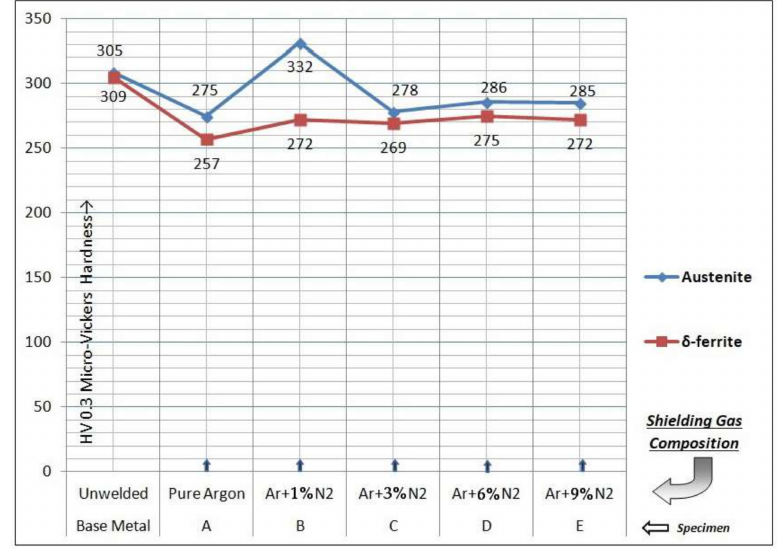
Figure 12. The effects of shielding gas composition on micro-hardness values of base metal and